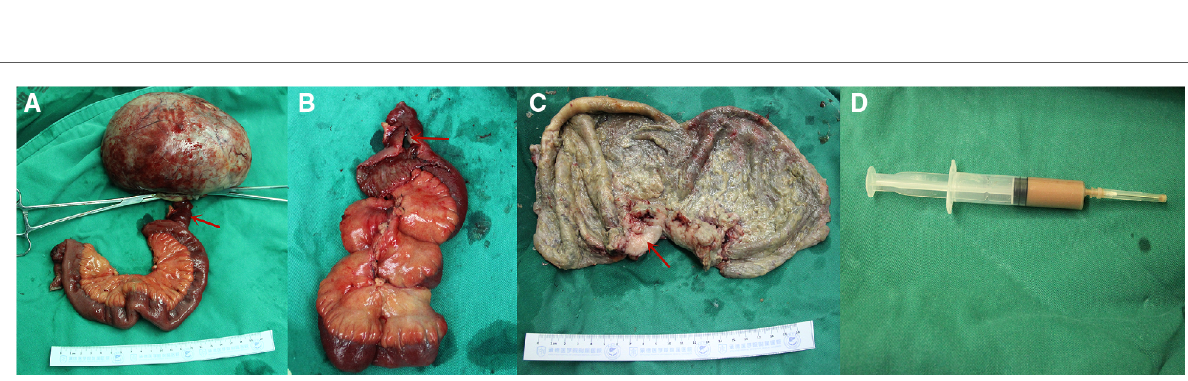
FIGURE 1 Ct scan showing a large cystic tumor in the lower abdomen with an unevenly thickened cystic wall, the solid component of the tumor (red arrow, A ), and mural nodules (red arrow, B ) with enhancement in the arterial phase. MRI revealed a large cystic tumor with an internal fl uid signal ( C ). CT, computed tomography; MRI, magnetic resonance imaging.